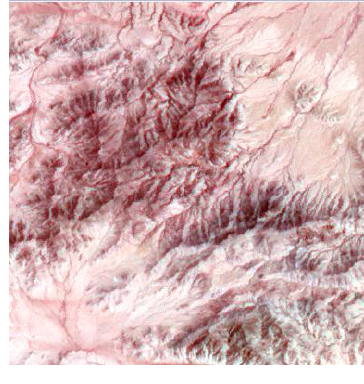
figure2. Remote sensing original image